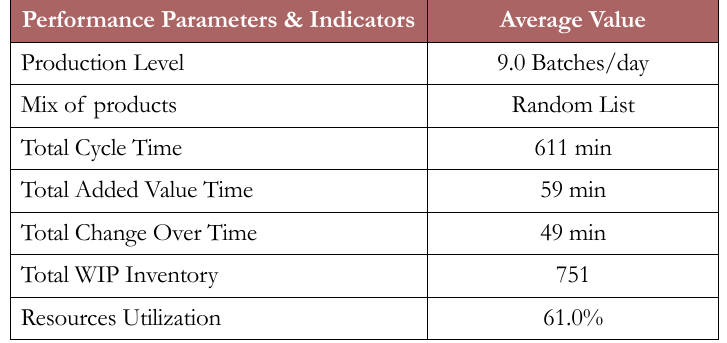
Table 3. Manufacturing Performances of